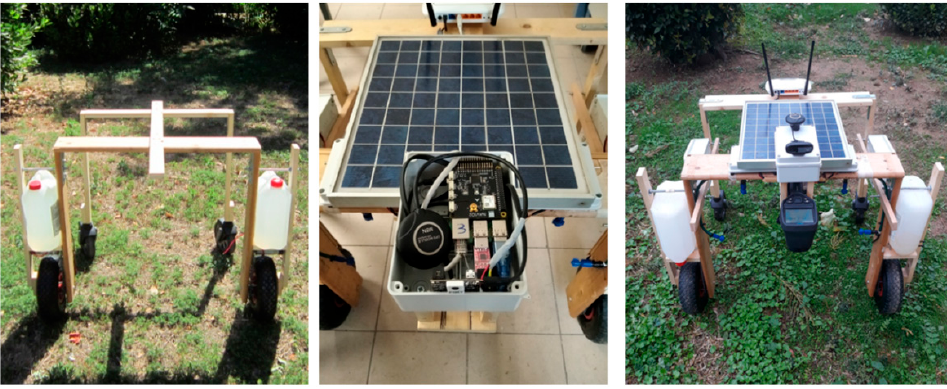
Figure 4. Indicative stages from the manufacturing process of the spraying robot, from its early wooden skeleton to the final whole.